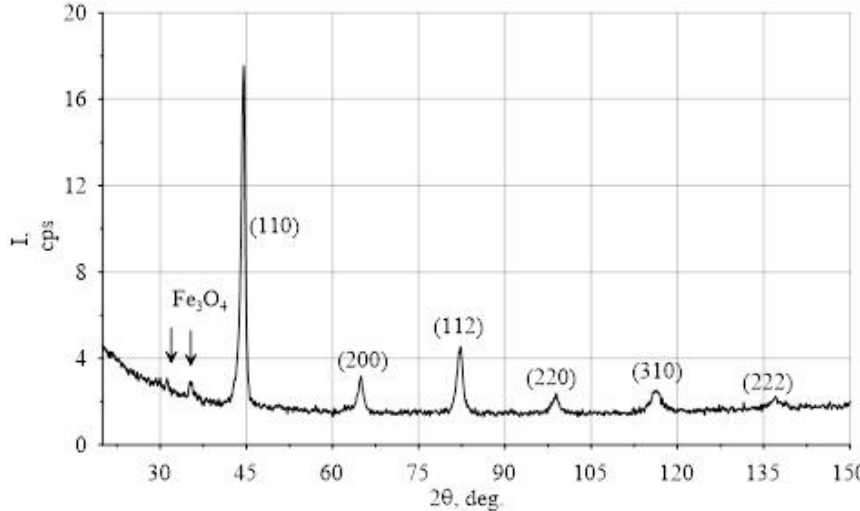
Figure 4. The diffraction spectrum of the surface layers of the shaft subjected to electromechanical processing (EMP). The figure shows the indices of X-ray reflections from the planes of the main phase (α-Fe). The arrows indicate the lines of the additional phase (iron oxide Fe 3 O 4 ).